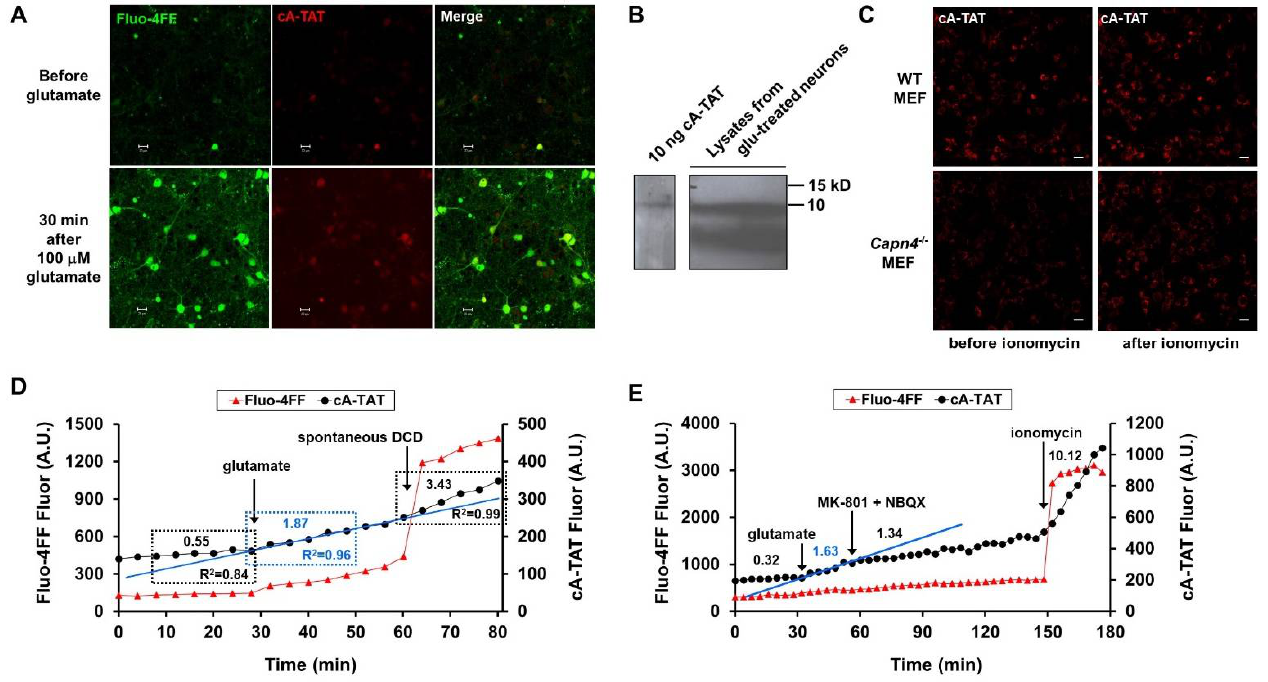
Figure 4. ( A ) Representative images of neurons loaded with Fluo-4FF (green) and cA-TAT (red) taken before and 30 min after glutamate (100 µ M) treatment. ( B ) Streptavidin–HRP Western blot comparing the size of bands observed in two different lysates of glutamate-treated neurons to the band observed when the cA-TAT molecule was loaded directly onto the gel. ( C ) Images of cA-TAT fluorescence in wild-type (top) and Capn4 knockout ( −/− , bottom) immortalized mouse embryonic fibroblasts (MEFs) after 20 min of baseline recording following the 80 min loading period (left panels, “before ionomycin”) and following treatment with ionomycin (5 µM) for 40 min (right panels, “after ionomycin”). Scale bars in A and C are 20 µm. ( D ) Fluo-4FF (left axis) and cA-TAT (right axis) fluorescence (fluor) values over time for a representative neuron exposed continuously to glutamate (100 µM) that subsequently showed spontaneous delayed Ca 2+ deregulation (DCD), as identified by the sudden jump in Fluo-4FF fluorescence (red trace). The dashed boxes highlight the data points for which the baseline, glutamate, and DCD rates were determined by linear regression analysis, with rates and R 2 values given in each box. ( E ) Fluo-4FF (left axis) and cA-TAT (right axis) fluores- cence values over time for a representative neuron sequentially exposed to glutamate (100 µM), a combination of the glutamate receptor antagonists MK-801 and NBQX to inhibit NMDA and AMPA-type receptors, respectively, and the Ca 2+ ionophore ionomycin. The solid blue lines drawn in D and E highlight the increased slope of cA-TAT fluorescence immediately following glutamate addition. A.U., arbitrary units/min.